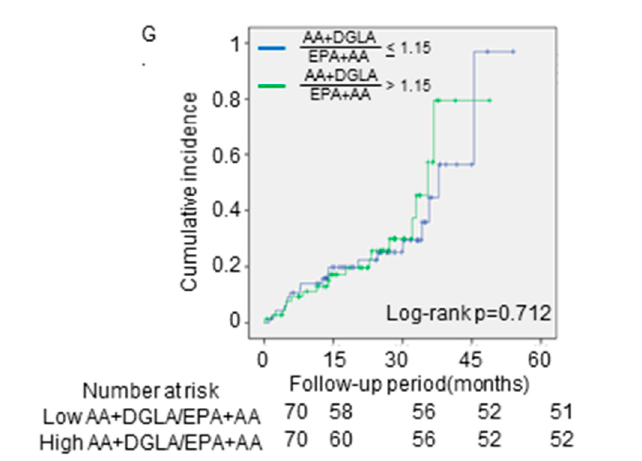
Figure 2. The associations between the primary outcomes and PUFA levels. The cumulative incidences of the primary endpoint (all-cause death) were estimated by using the Kaplan–Meier method. The patients were divided into two groups, based on the median levels of ( A ) EPA, ( B ) DHA, ( C ) AA, ( D ) DGLA, ( E ) EPA/AA, ( F ) DHA/AA, and ( G ) AA + DGLA/ EPA + DHA. Log-rank testing was performed to study the influence of PUFA levels on primary endpoint. EPA, eicosapentaenoic acid; DHA, docosahexaenoic acid; DGLA, dihomo-gamma-linolenic acid; AA, arachidonic acid;